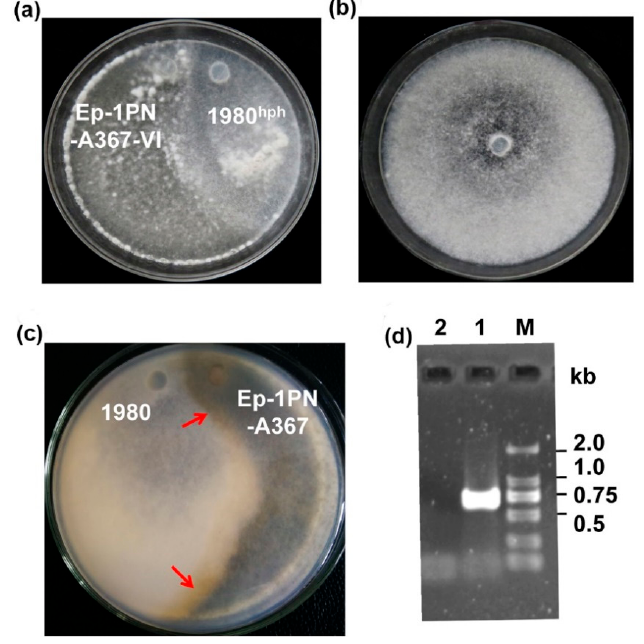
Figure 7. SsDFV2 can be transmitted from S. sclerotiorum strain Ep-1PNA367VI to its vegetative incompatible strain, 1980. ( a ) Dual-culture colonies; ( b ) Virus-infected strain (1980) colony; ( c ) Colonies in dual-cultures of strains Ep-1PNA367 and 1980 grown for 7 days, showing the vegetative incompatibility reaction area (red arrow). ( d ) Virus detection in the virus-infected strain, 1980, by RT-PCR amplification using SsDFV2 sequence-specific primers. Lane M, DL2000 DNA Marker; Lane 1, SsDFV2 specific band; Lane 2, ddH 2 O.